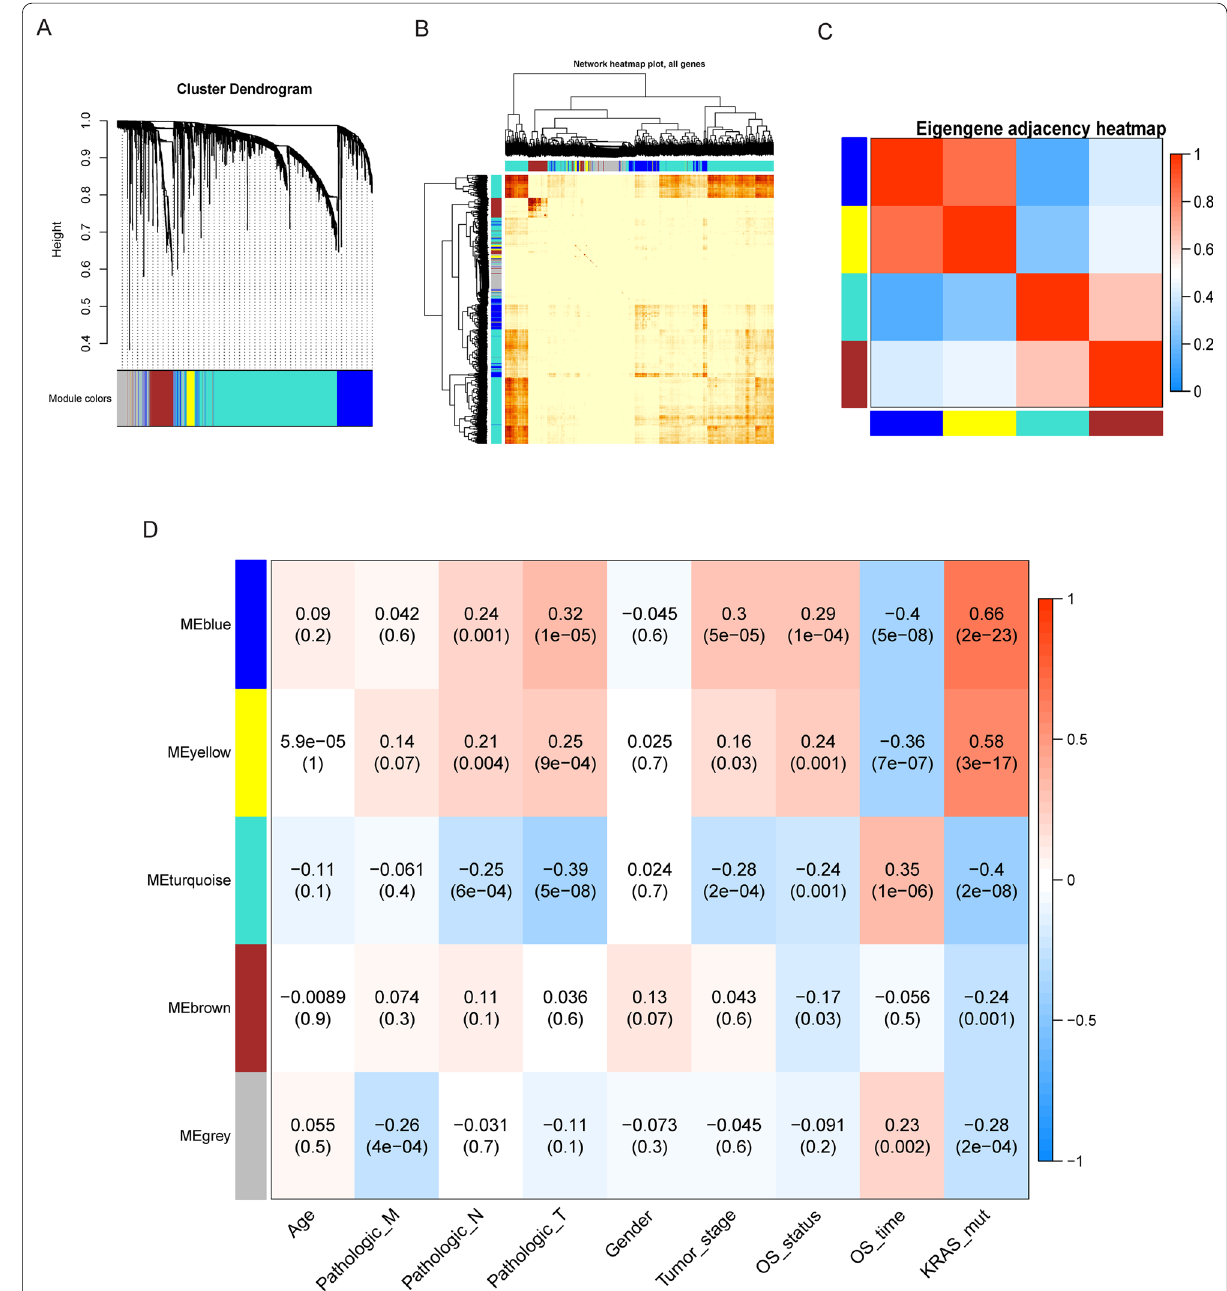
Fig. 4 WGCNA analysis results. A Clustering results. Cluster dendrogram and the co-expression network modules identified in average linkage hierarchical clustering of DEGs based on topological overlaps. Each branch within the dendrogram represents a single gene. Height represents the Euclidean distance. Each color indicates a single module containing weighted co-expressed genes; B Weighted network heat map of all genes; C Eigengene adjacency heatmap. The heatmap illustrates the relationship among the distinctive co-expression modules; D Heat map of correlation between the modules and the phenotypes. Each row represents a color module, and each column indicates a clinical trait. Each cell contains the R 2 values of Pearson’s correlations between the modules and the clinical features, and the corresponding P -values are inside the parentheses. The gradient color of each cell indicates the R 2 values of Pearson’s correlations (red 1, blue 1). DEGs differentially expressed genes; ME module = = −